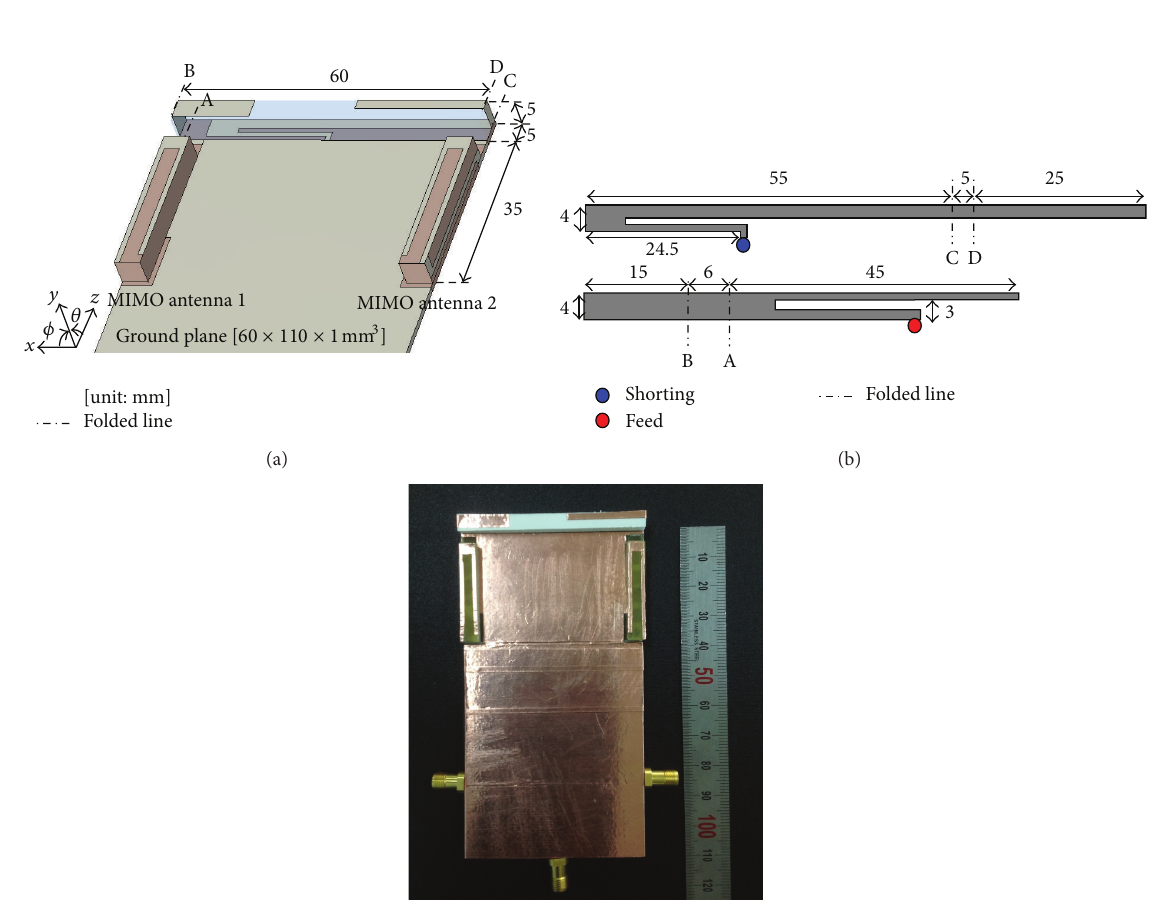
Figure 5: Geometry of the proposed antenna; (a) overall view, (b) detailed view of main antenna, and (c) fabricated